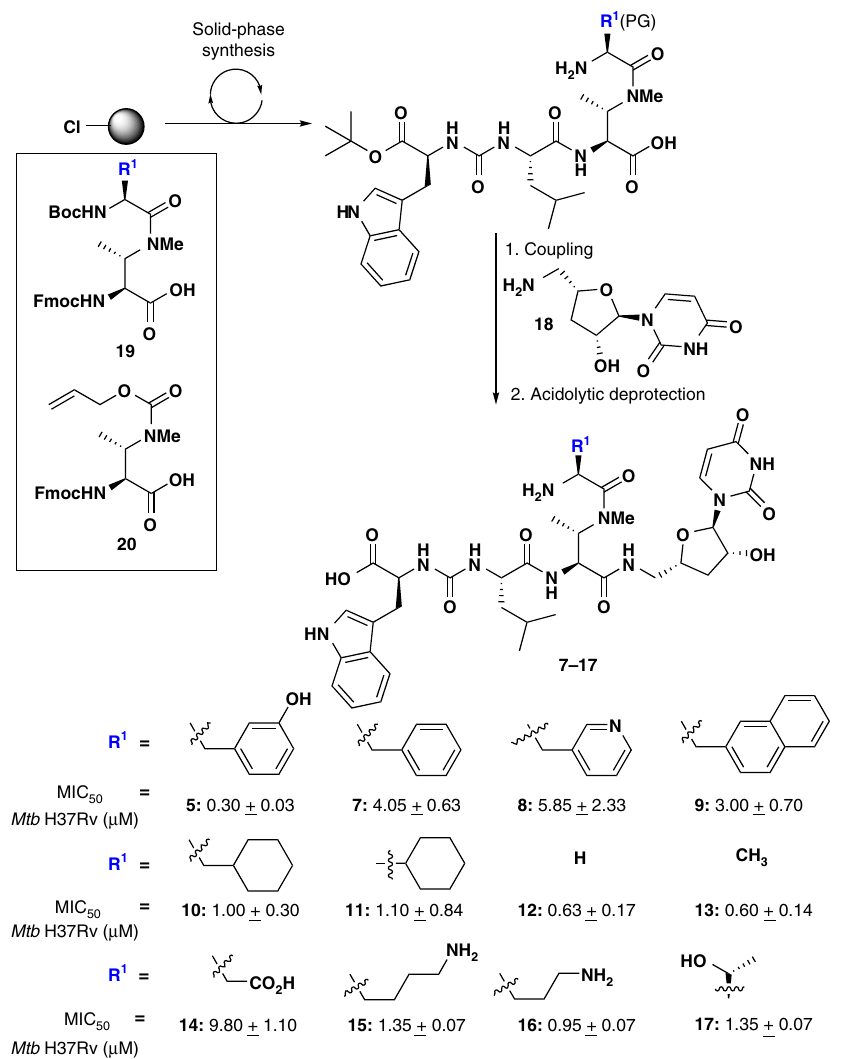
Figure 2 | Synthesis of 1st generation sansanmycin analogues 7–17 with inhibitory activities against Mtb H37Rv. PG ¼ side chain protection necessary for the synthesis of 5 , 14 , 15 and 16 . MIC 50 values represent an average of two independent experiments each performed in triplicate; positive controls RIF: 0.006 ± 0.002 m M; INH: MIC 50 ¼ 0.025 ± 0.005 m M; MIC 50 (HEK293) for 7–17 4 200 m